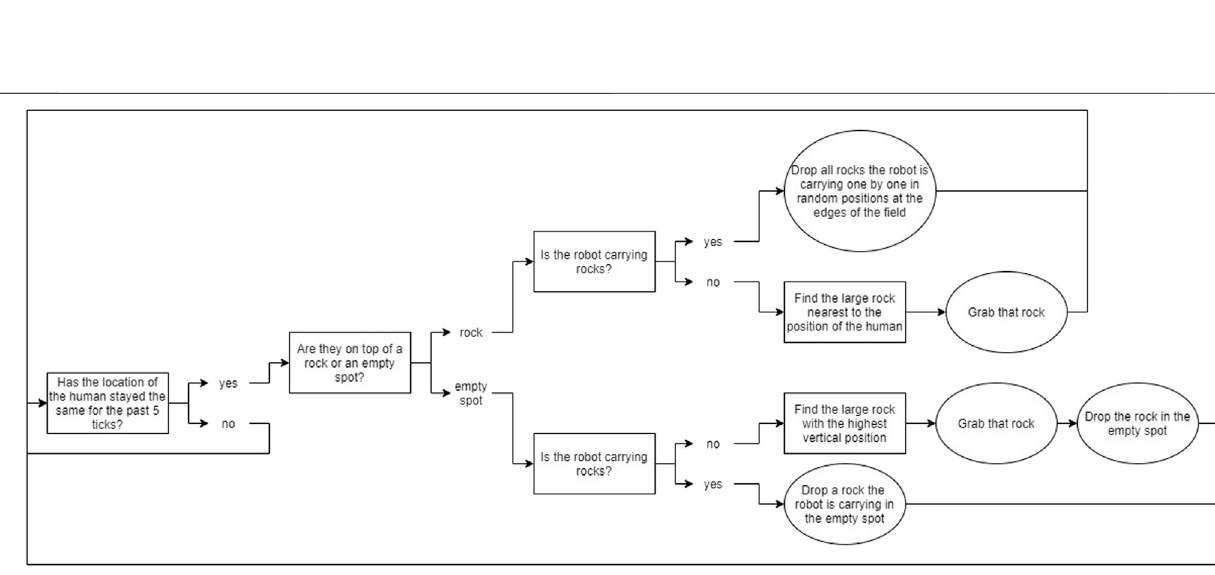
FIGURE 4 | A fl owchart showing the rule-based decision making the agent would go through when using Macro-Action 2.